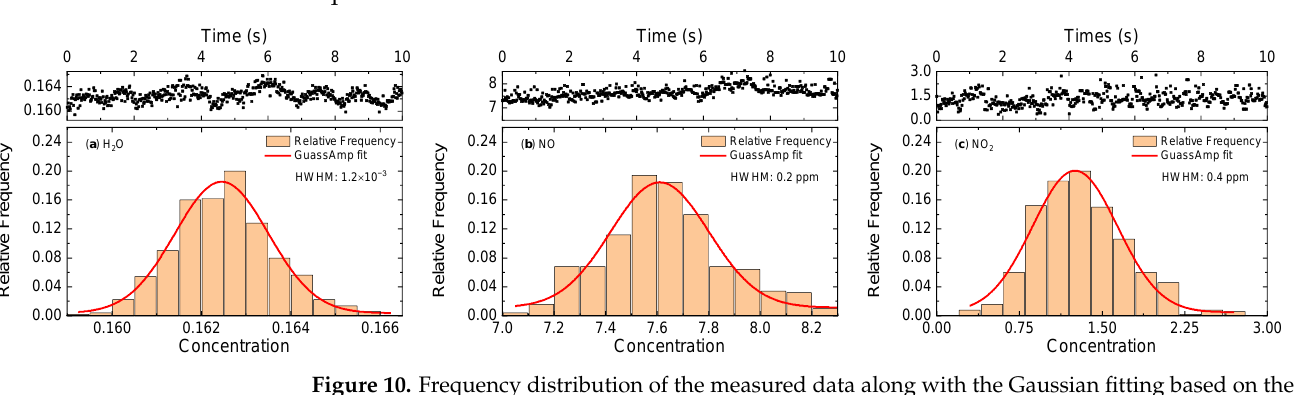
Figure 10. Frequency distribution of the measured data along with the Gaussian fitting based on the time-resolved measurements of ( a ) H 2 O, ( b ) NO, and ( c ) NO 2 at Φ = 0.89. The sensor measurement resolution can be reflected by the 2 s noise, which was cal- culated using the values obtained from the RMS noise. Despite the H 2 O interference hav- ing been eliminated as much as possible, the 2 s noises of the NO 2 measurement were estimated to be ~1 ppm. The NO x generation decreased with the further reduction in the equivalence ratio due to the lower adiabatic flame temperature. Therefore, it was not effi- cient to measure NO 2 at Φ = 0.78 and 0.73 since the random noise was higher than the predicted concentration. Extra data about the concentrations and uncertainties of these three components are listed in Table 2. The flame number and the corresponding equiva- lence ratio of the flat flame are also listed. Table 2. Species mole fractions measured by TDLAS are listed beside the reference values calculated using Chemkin or measured by a gas analyzer.